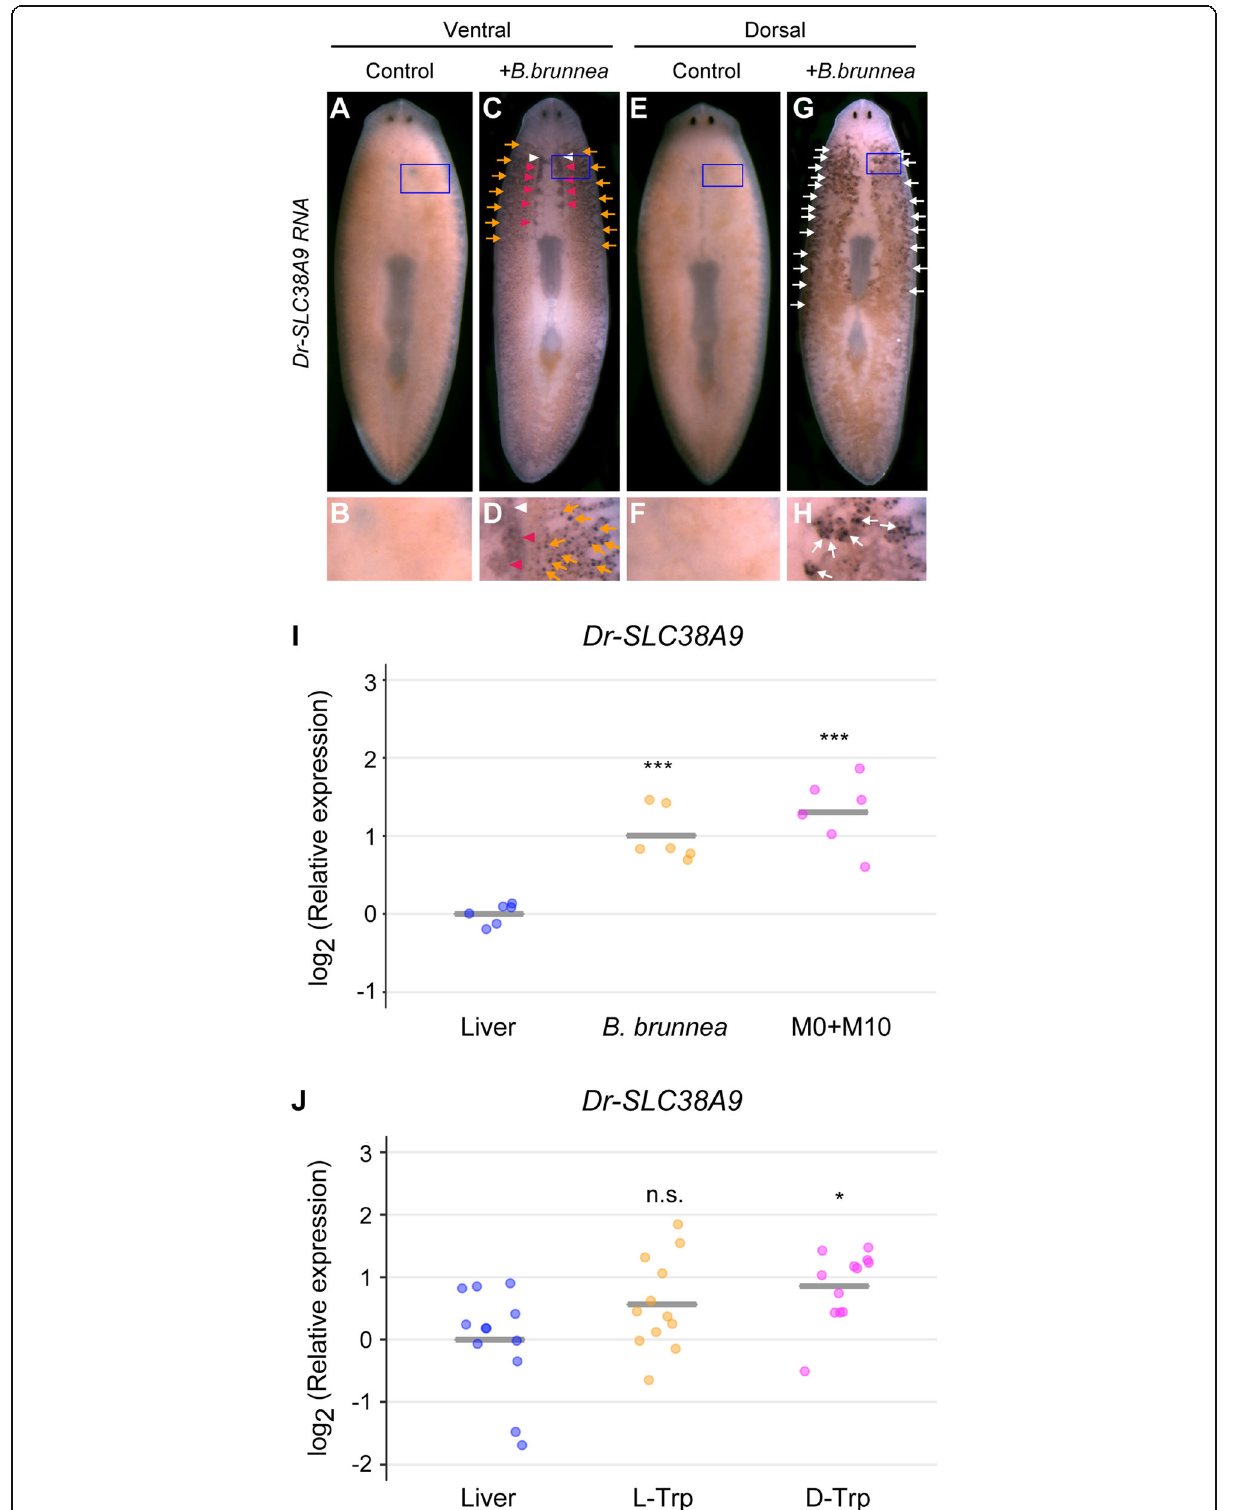
Fig. 5 (See legend on next